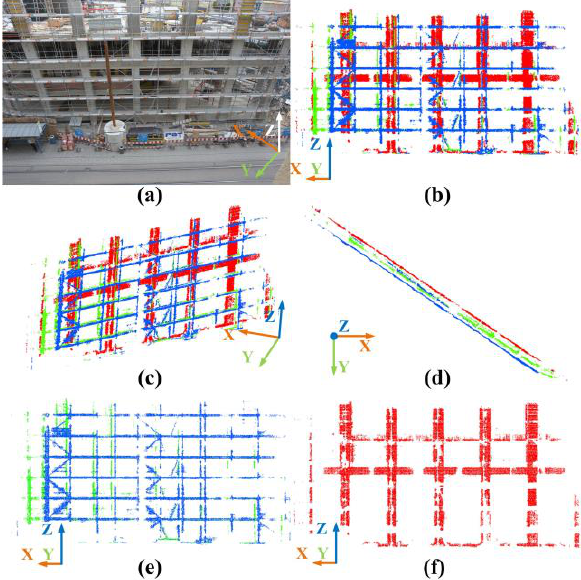
Figure 9. a) The original image of the building façade, b)-d)